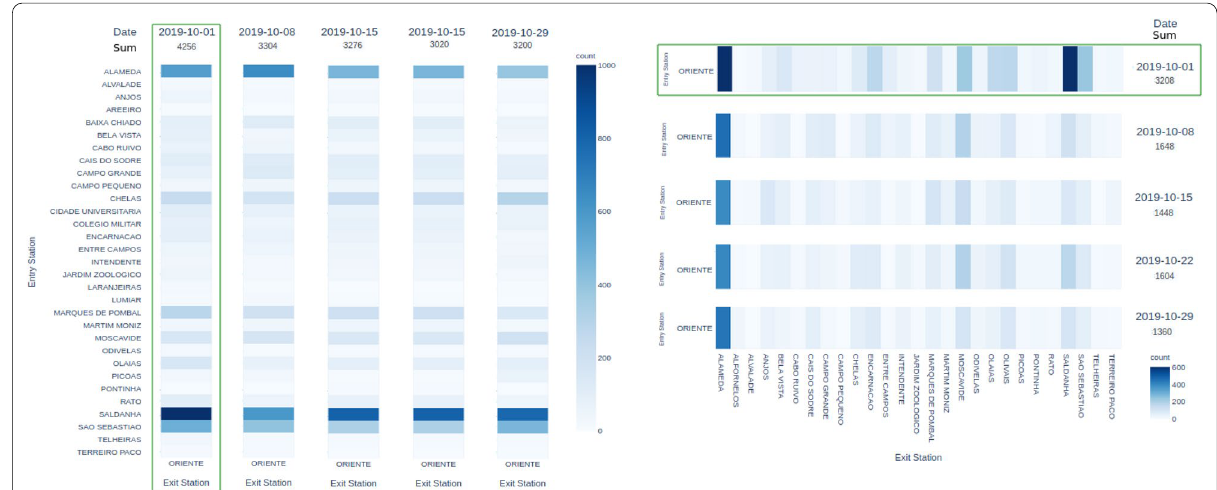
Fig. 8 Total passenger exit and entry counts, respectively, at Oriente subway station: impact of concert in October 1st,